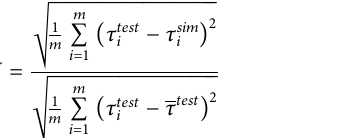
Frontiers in Materials |